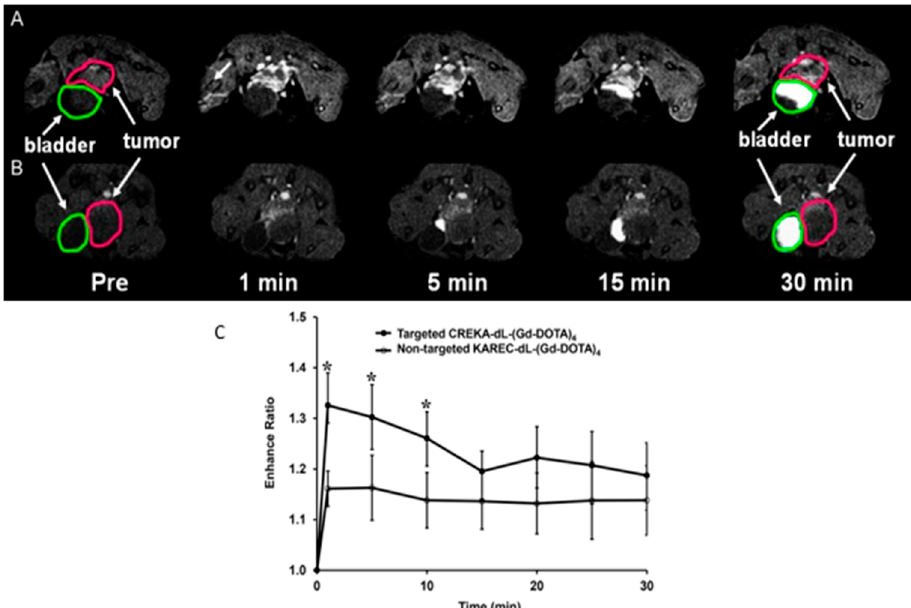
Figure 3. Illustration of signal amplification of CREKA-dL-(Gd-DOTA) 4 from Wu et al. 2014 (mod- ified); ( A ) T1-weighted axial 2D images of orthotopic prostate cancer mice model before and at different time points after injection of CREKA-dL-(Gd-DOTA) 4 . ( B ) T1-weighted axial 2D images of orthotopic prostate cancer mice model before and at different time points after injection of KAREC-dL-(Gd-DOTA) 4 . The animals were injected with 0.03 mmol-Gd/kg in nu/nu nude mice. ( C ) Signal amplification ratio in tumor tissue: The ratio of signal intensity after contrast agent administration to that before contrast agent administration, up to 30 min after contrast agent injection, * p < 0.05.